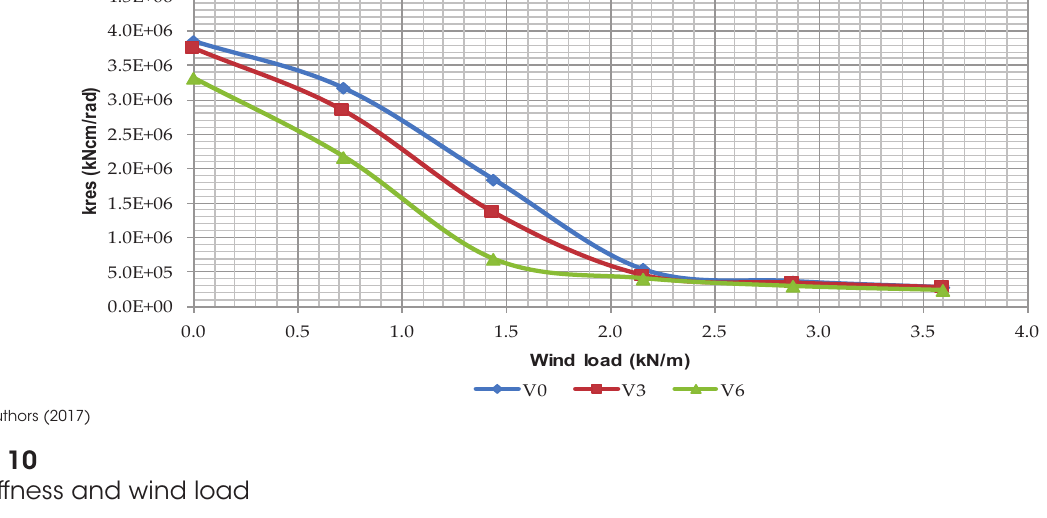
Figure 10 Roll stiffness and wind